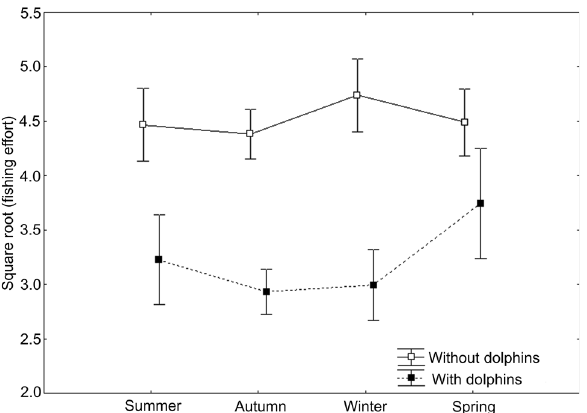
Figure 13. Seasonal variation in fishing effort. Means and standard deviations of the effort in the presence or absence of dolphins.